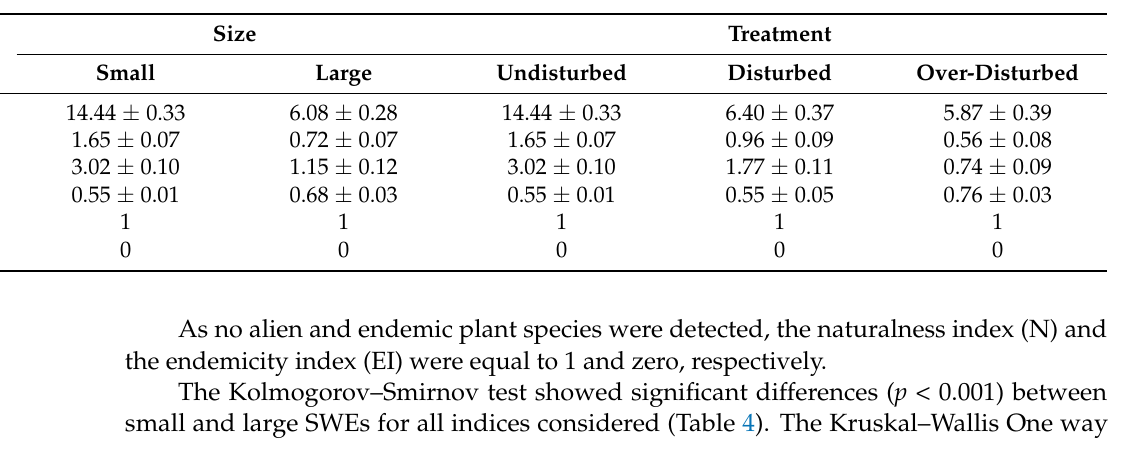
Table 3. Summary of the mean values ( ± ES) of diversity indices calculated separately based on the SWEs’ size and disturbance